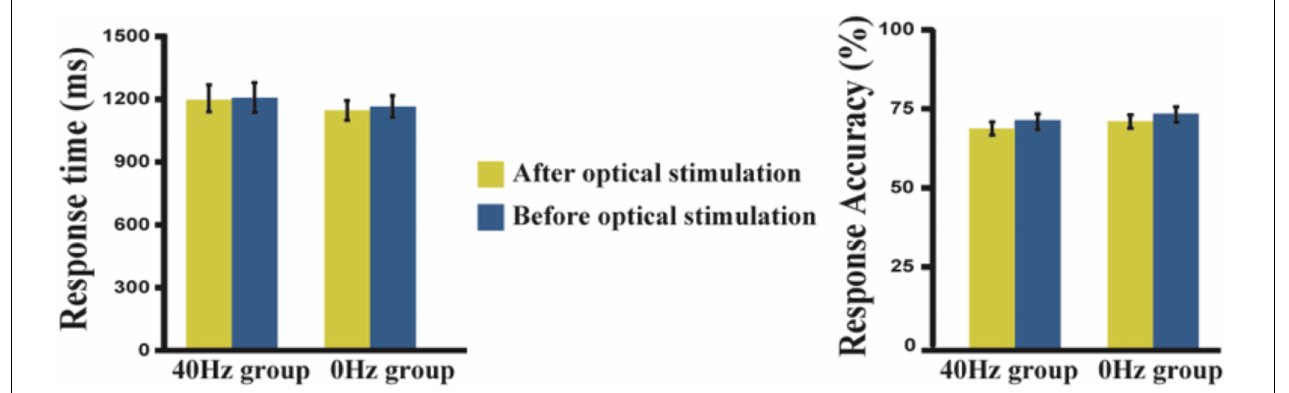
FIGURE 2 | Response time and accuracy in the 40-Hz group and 0-Hz group. A two-way ANOVA result shows that neither the main effect nor an interaction can be observed. Yellow bar, after light exposure; Blue bar, before light exposure. The error bars show the standard deviation of the